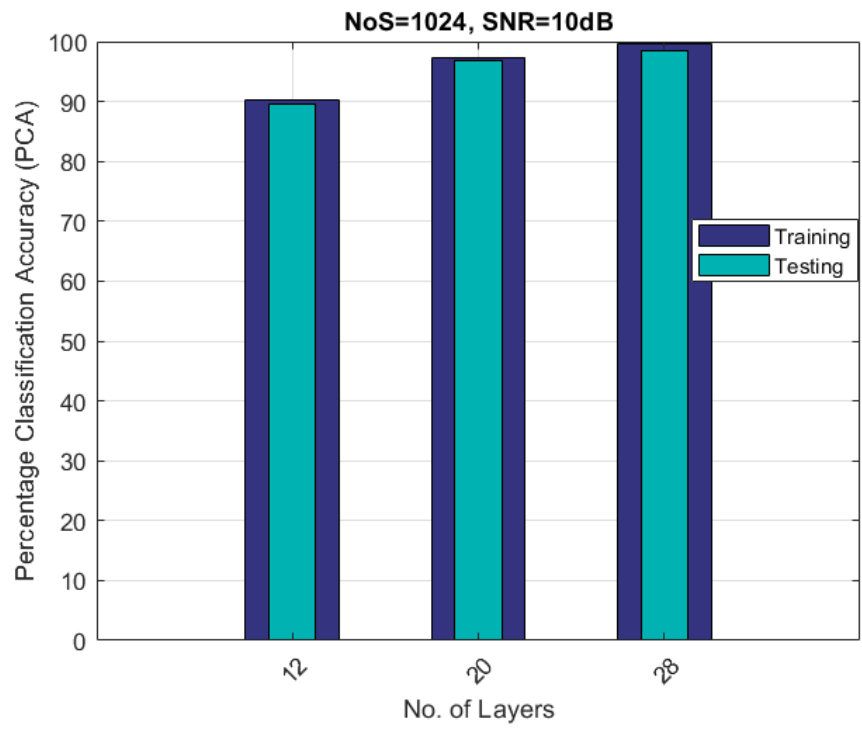
Figure 9. PCA vs. No. of